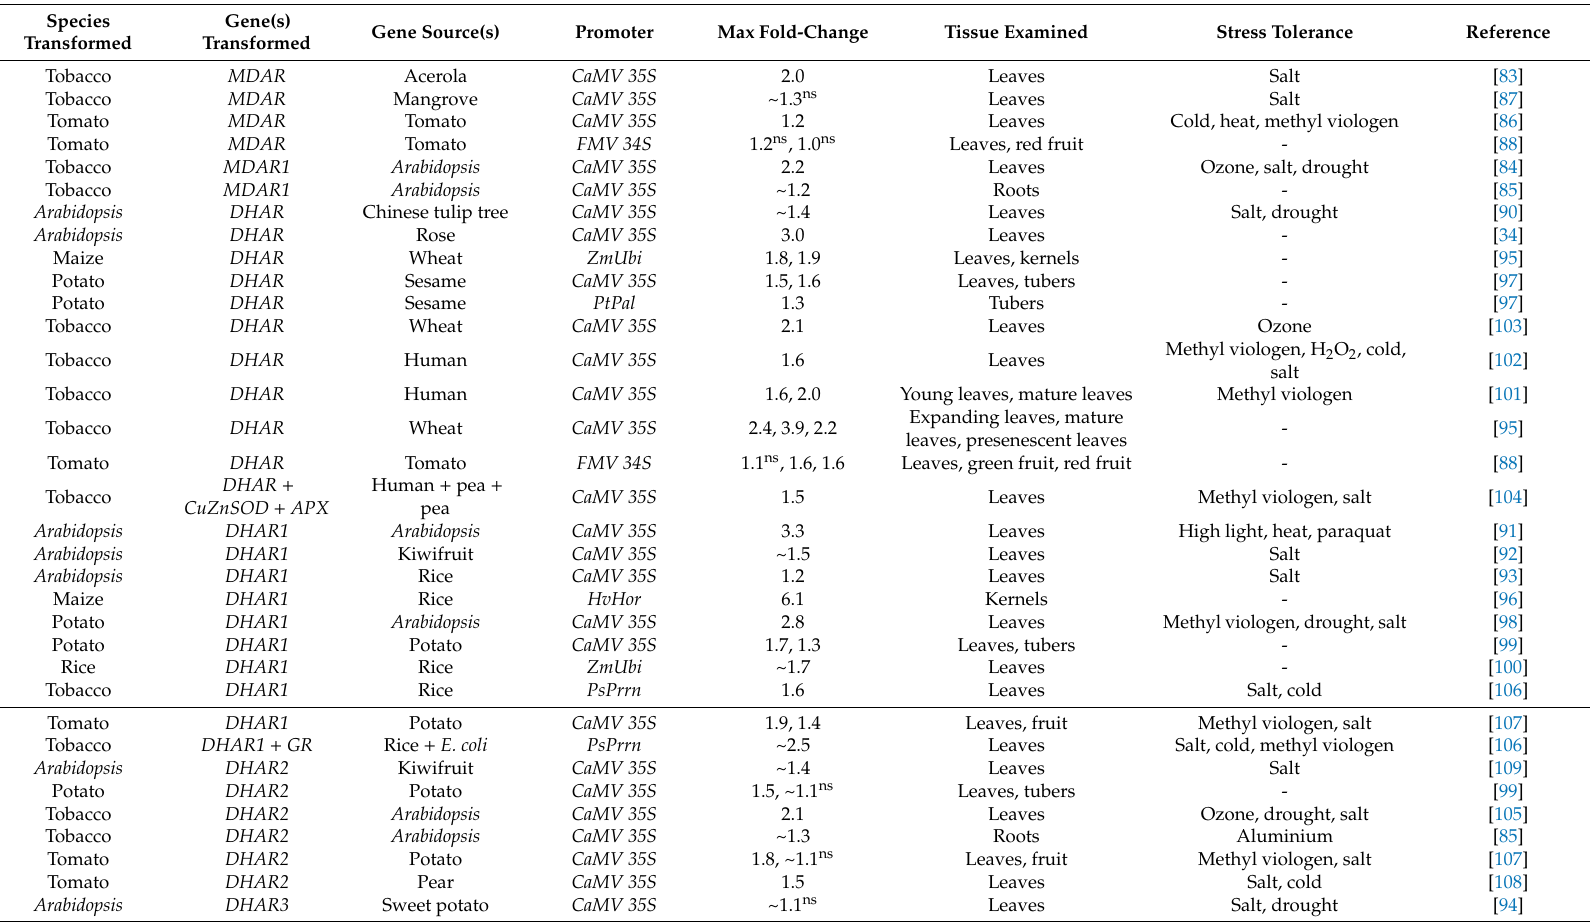
Table 2. Overview of metabolic engineering strategies utilizing ascorbate recycling genes to increase ascorbate concentrations in model and crop species. Species